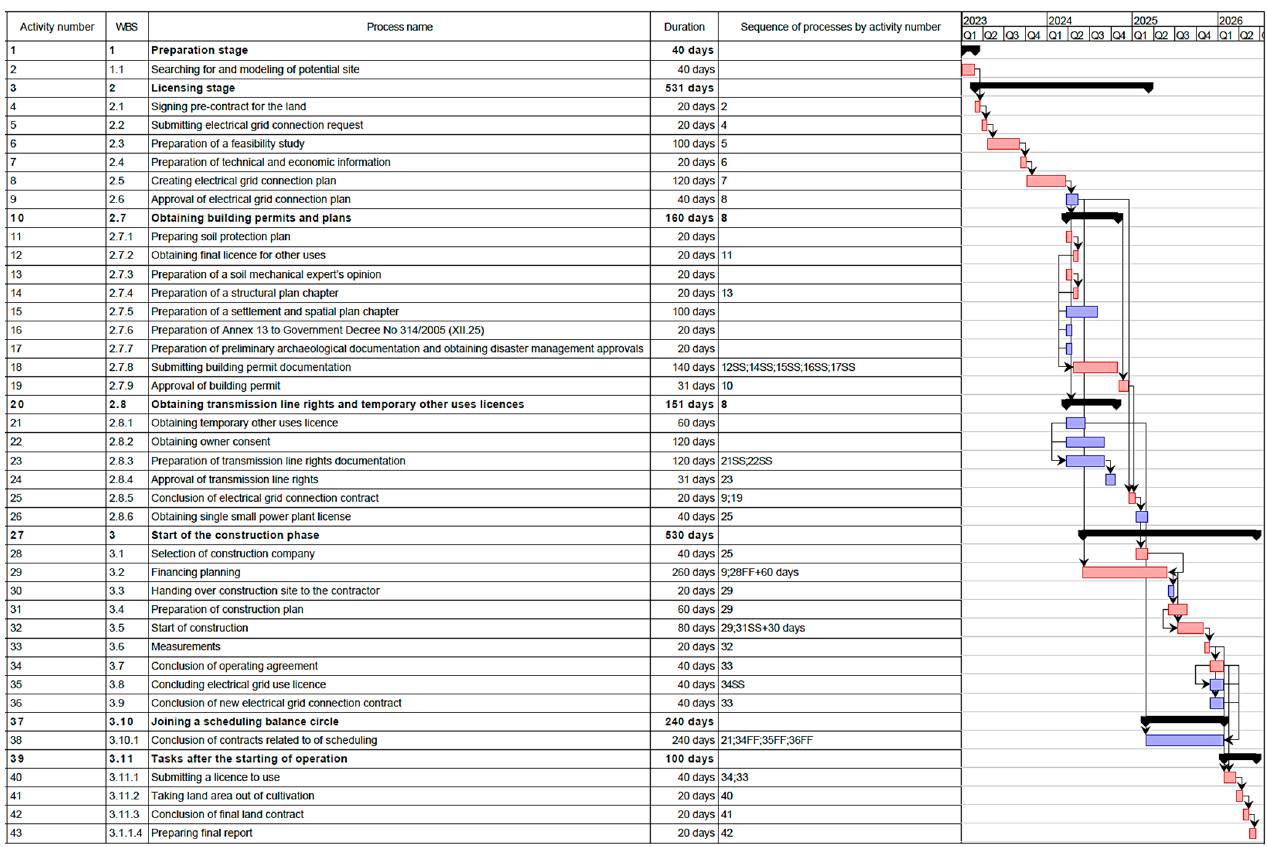
Figure 2. The summary of the process of establishing solar power stations in Hungary.